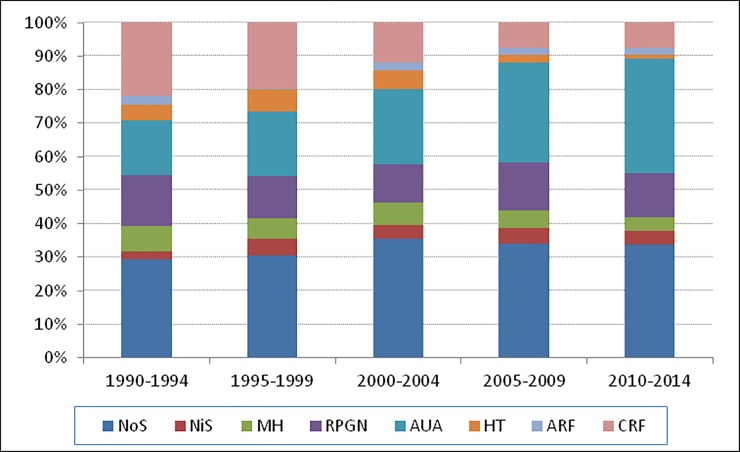
Clinical presentation by era.Uruguay 1990–2014. 1990-2014.NoS Nephrotic syndrome; NiS Nephritic syndrome; MH Macroscopic hematuria; RPGN rapidly progressive Glomerulonephritis; AUA urinary asymptomatic abnormalities; HT Hypertension; AKI Acute kidney injury; CKD Chronic kidney disease.